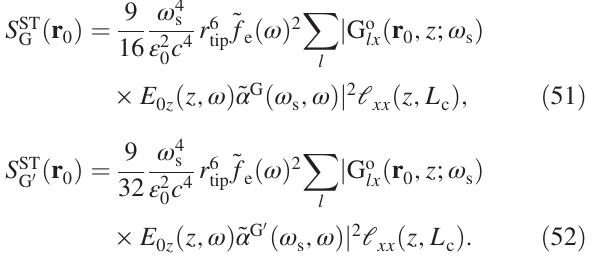
FIG. 7. Comparison of original function (top panel) and approximation (bottom panel) according to Eq. (43), for j ¼ x . The following fitting constants were used: a 0 0 ¼ 0 . 78 , b 0 0 ¼ 2 . 4 , c 0 0 . 18 , and d 0 0 . 56 0 ¼ 0 ¼